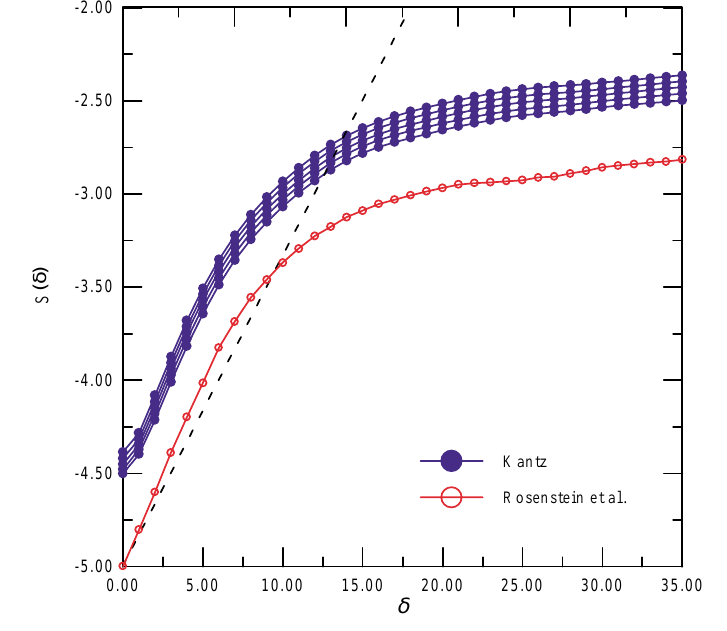
Fig. 10. Chaotic signal: S ( δ )